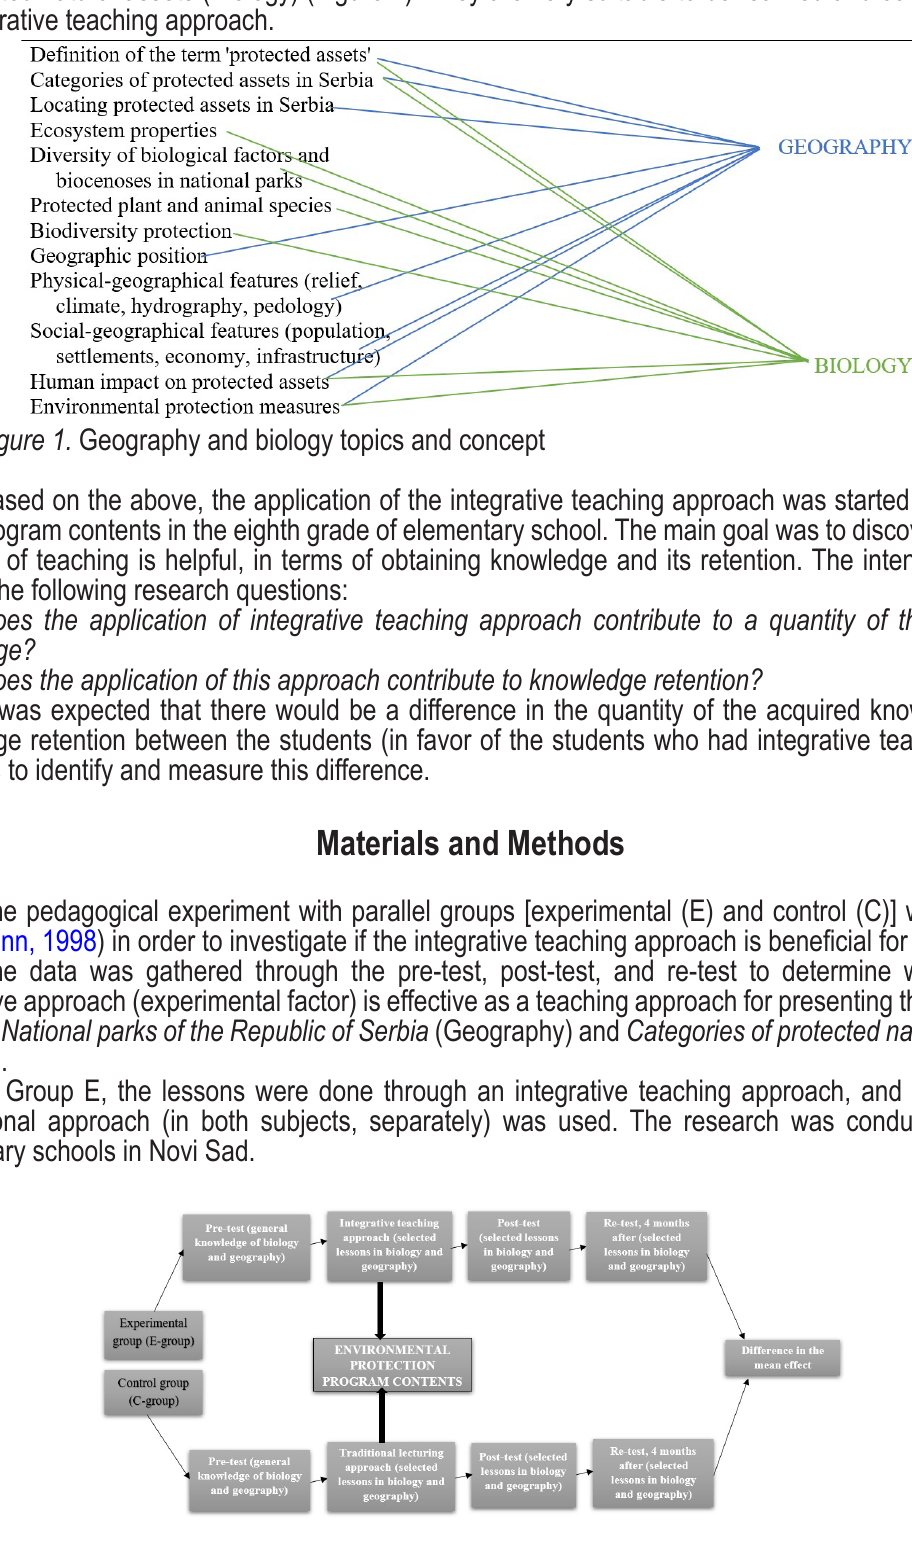
Figure 2. Research